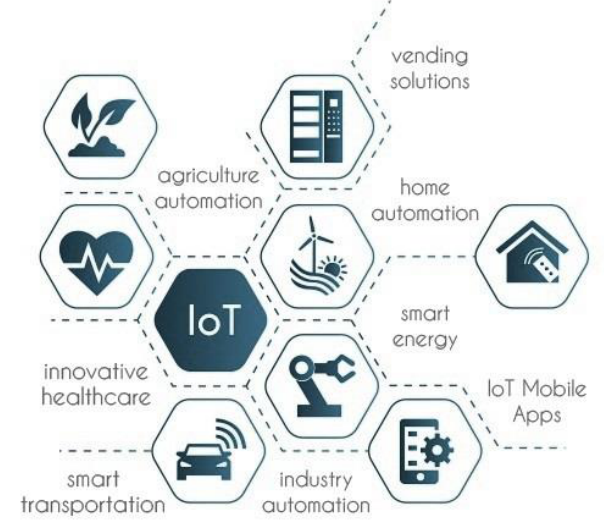
Figure 2. IoT applications in different